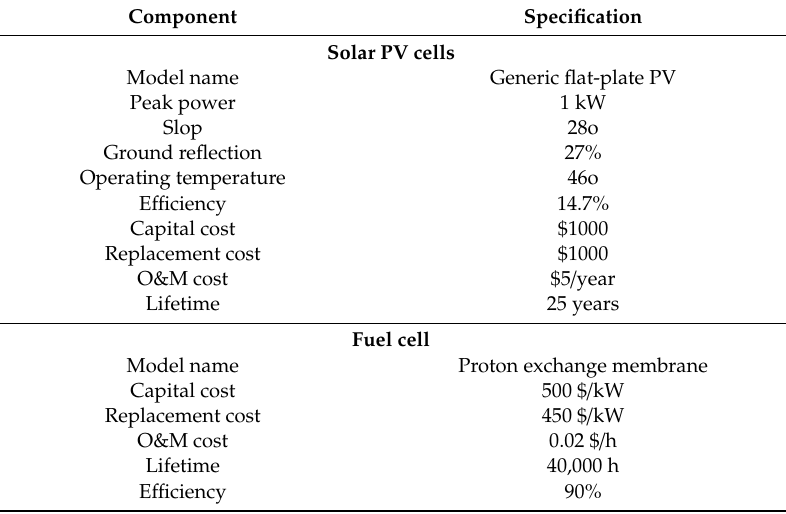
Table 2: model name: generic flat-plate PV; peak power: 1 kW; slope: 28°; ground reflection: 27%; $5/year; lifetime: 25 years. Table 2. Summary of proposed renewable energy system components.